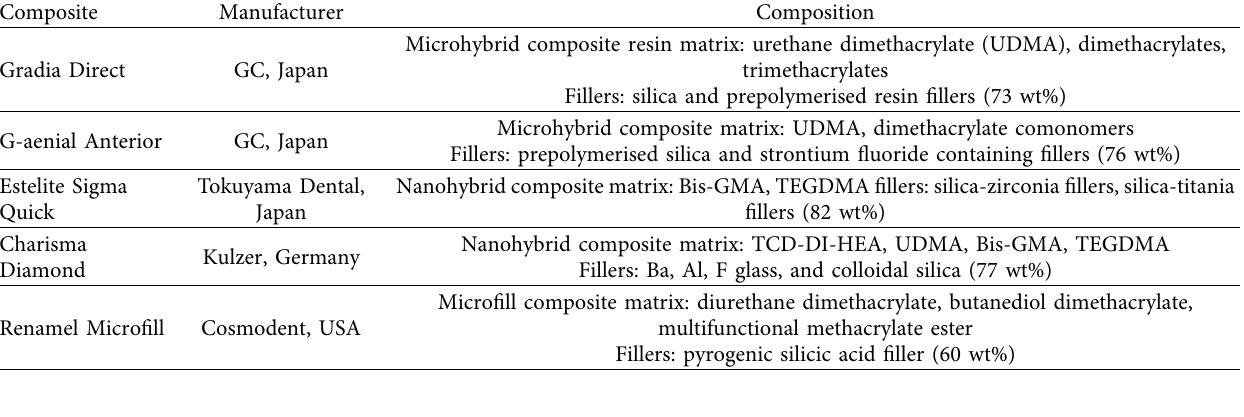
Table 2: Materials used in the study.